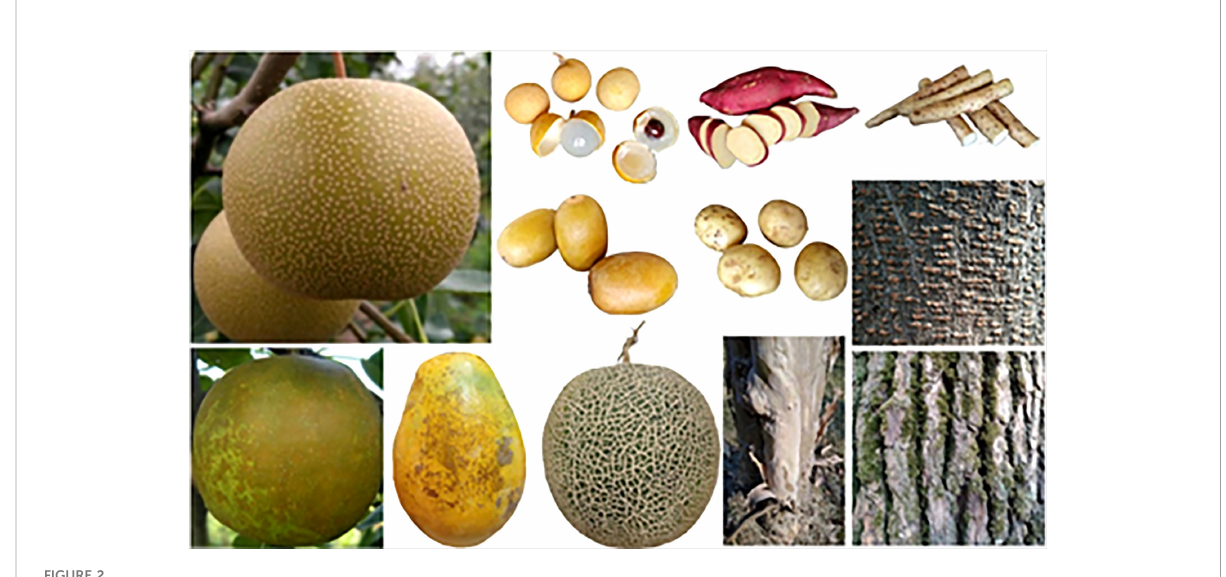
FIGURE 2 Appearance of different types of